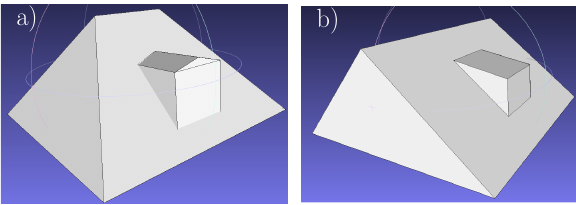
Figure 1. Roof models with different dormer types: a) gabled dormer and b) shed